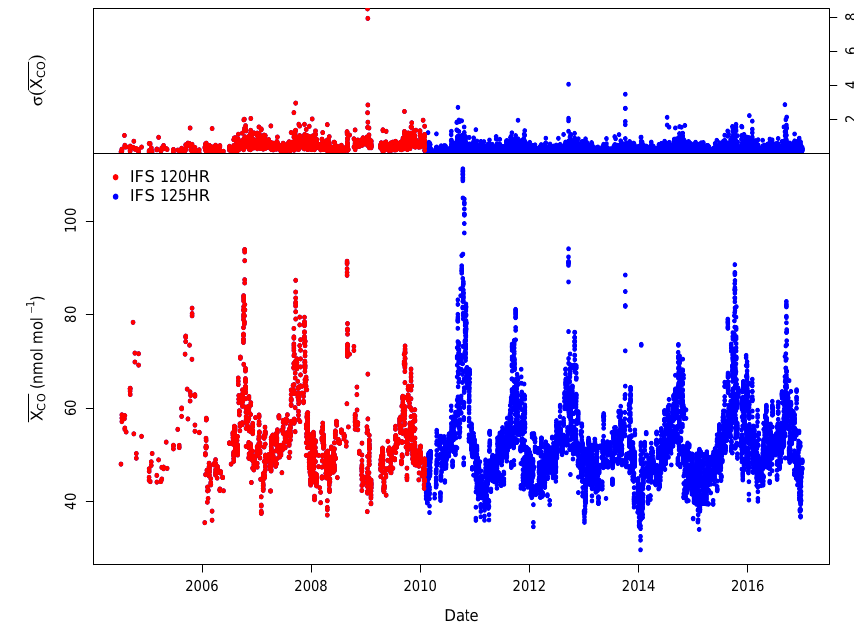
Figure 11. Time series of hourly means of X CO retrieved from measurements made with both FTS instruments at Lauder.